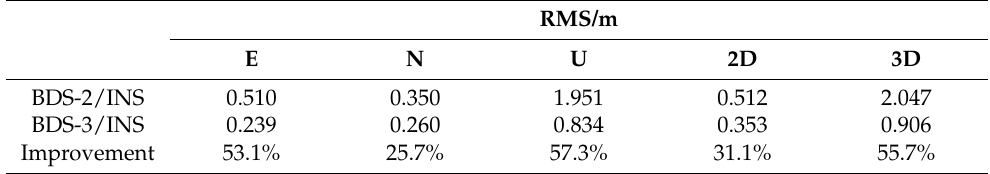
Table 7. Positioning error statistics of the BDS-2/INS and BDS-3/INS tightly coupled.